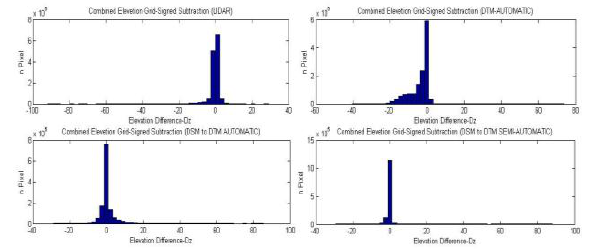
Figure 3. Histogram comparison of each method on map sheet 1209-1415D